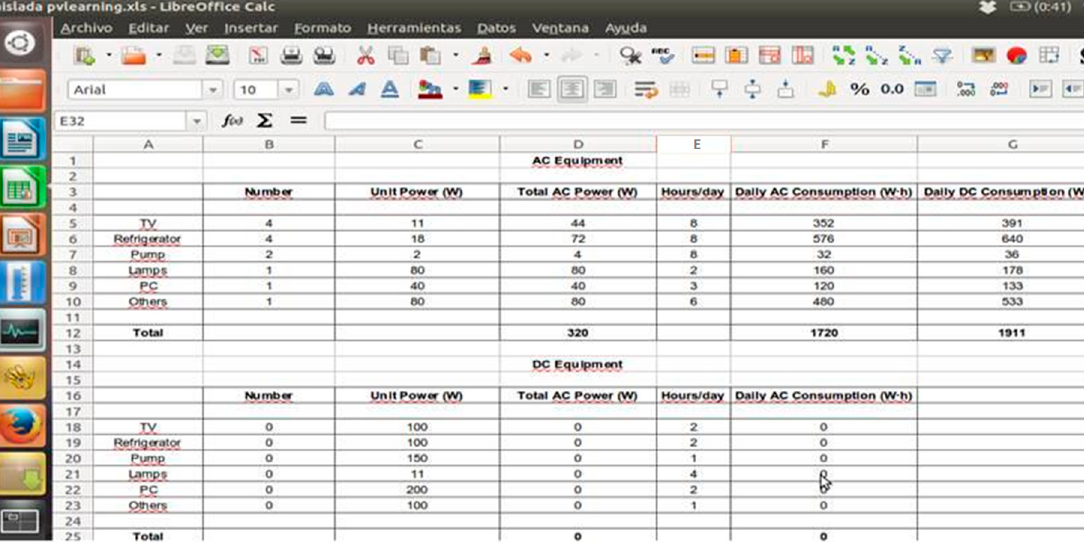
Figure 2. Tool developed for the simulation of photovoltaic isolated